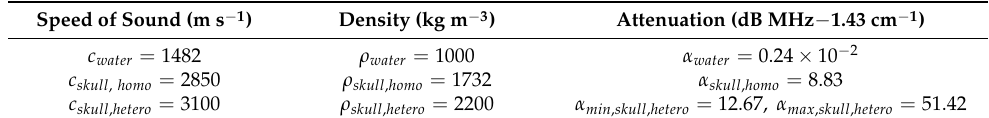
Table 2. Acoustic parameters used for simulation design [44–47].